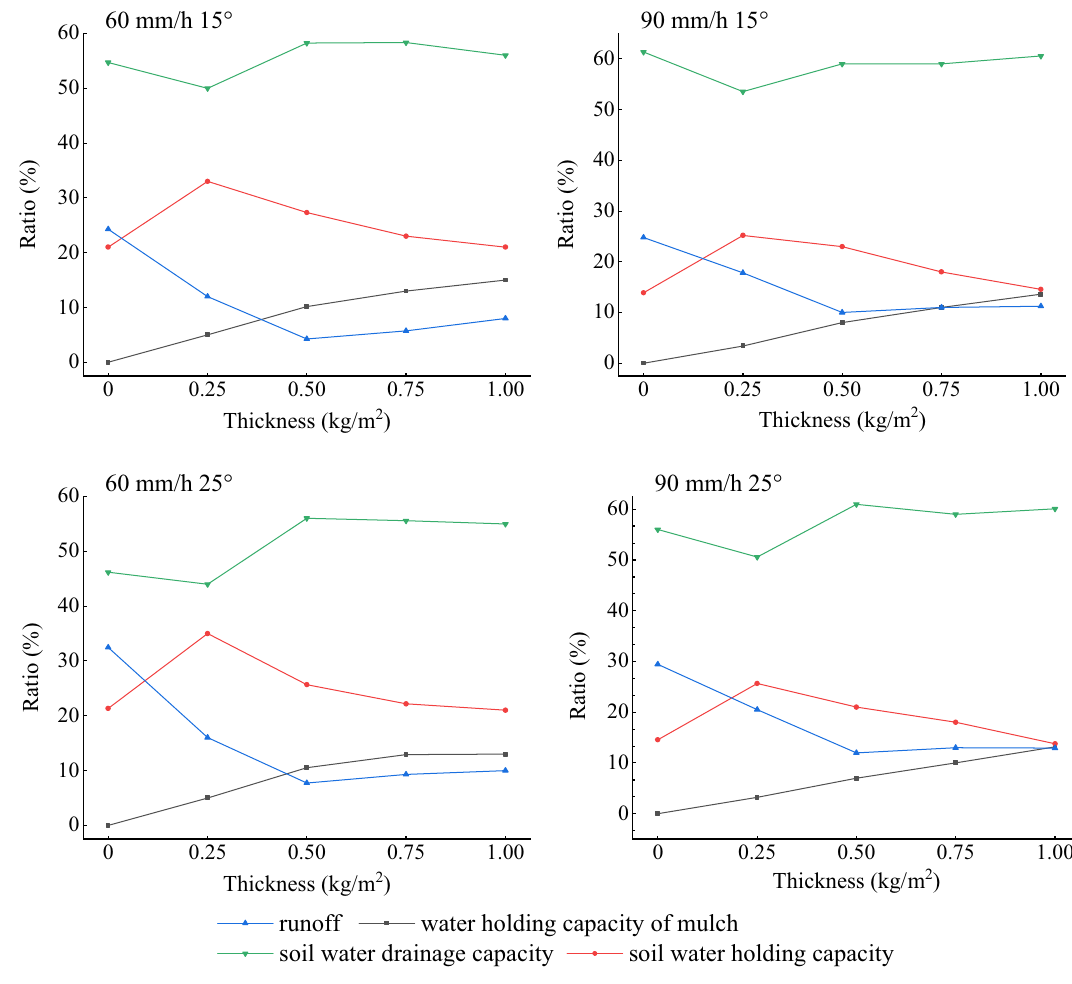
Figure 7. Relationship between water balances from rainfall input depending on mulch application.